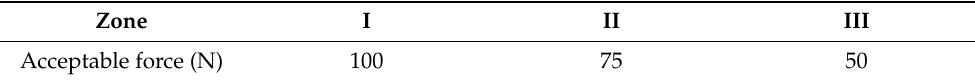
Table 1. Acceptable force limits foreseen by the OECD Code no. 6 for raising/lowering